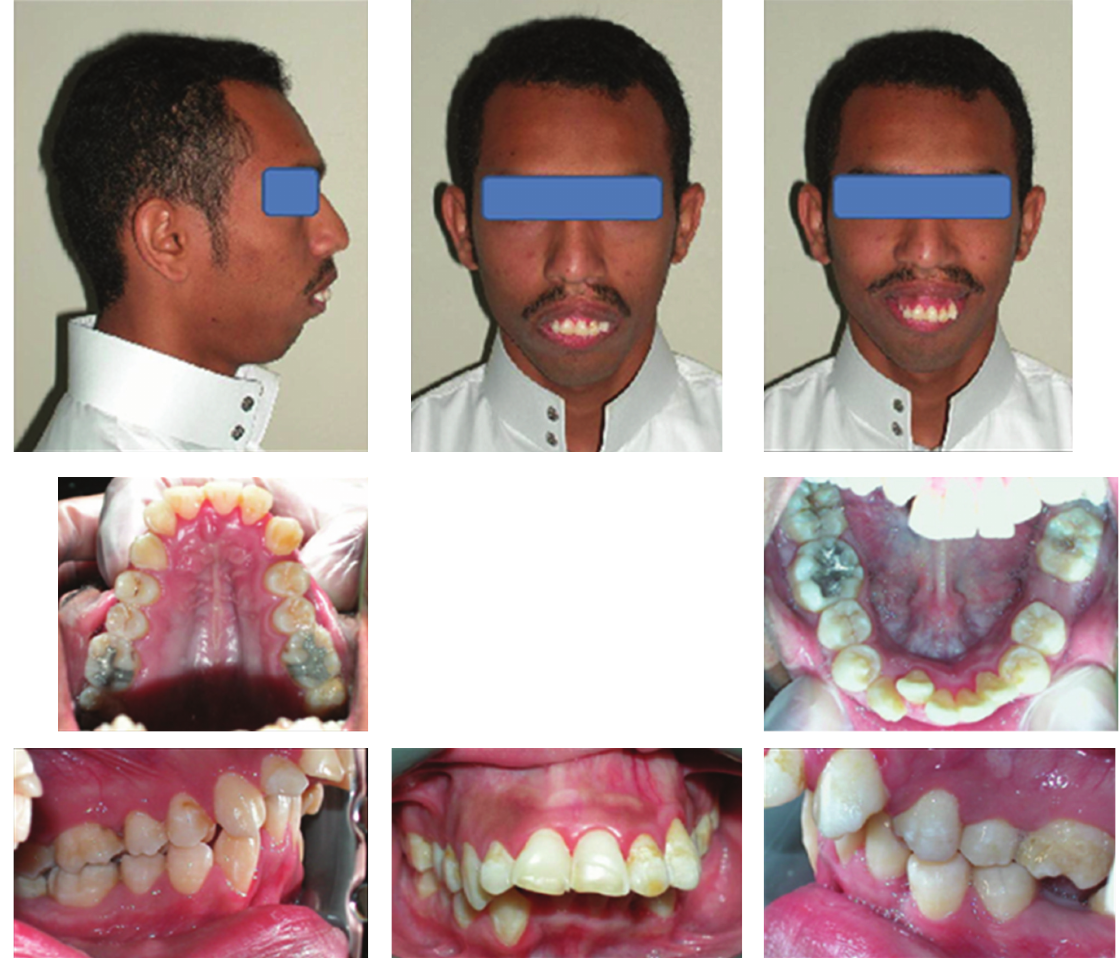
Figure 1: Pretreatment extraoral and intraoral